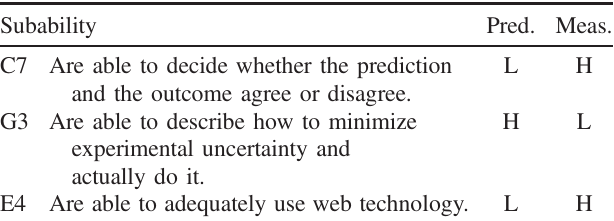
TABLE XIII. A list of abilities for which there is a two level difference between our prediction and the measured difficulty